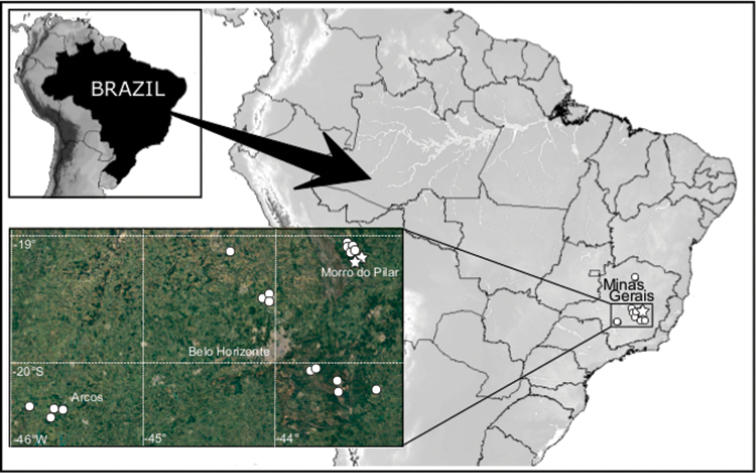
Distribution maps of Cuacuba
mariana sp. n. (circle) and C.
morrodopilar sp. n. (star) in state of Minas Gerais, Brazil.